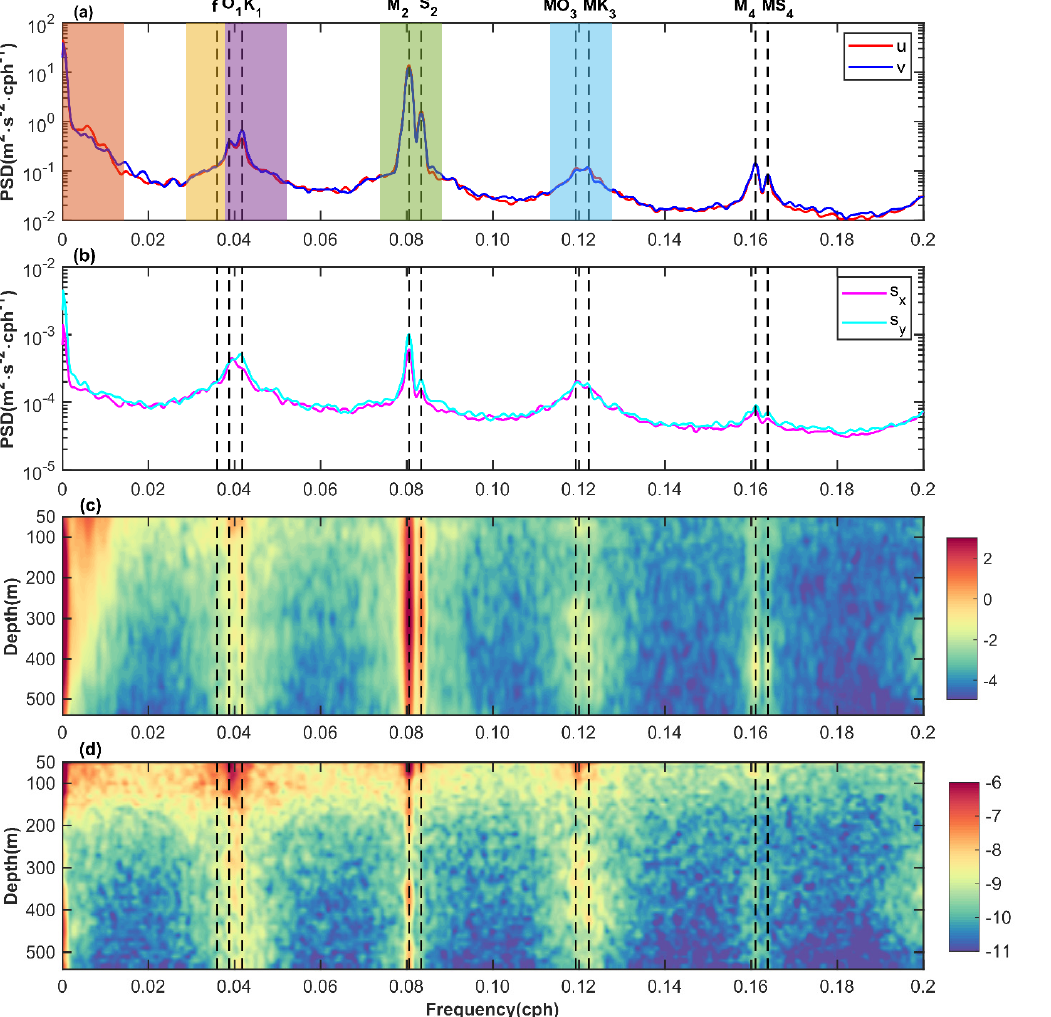
Figure 2. Depth-averaged power spectra of the currents ( a ) and total shear ( b ) in OP3, and the red (magenta) and blue (cyan) lines indicate the zonal and meridional components of the currents (total shear), respectively. The orange, yellow, purple, green, and light blue shadings denote cutoff frequencies for SICs; NIWs; and D1, D2, and D3 ITs in ( a ), respectively. Depth–frequency plot of the log of power spectral densities (shading) of the zonal currents ( c ) and total shear ( d ). The black vertical dashed lines denote the local inertial frequency ( f ) and dominant tidal frequencies O 1 , K 1 , M 2 and S 2 as well as their harmonic frequencies MO 3 , MK 3 , M 4 and MS 4 .